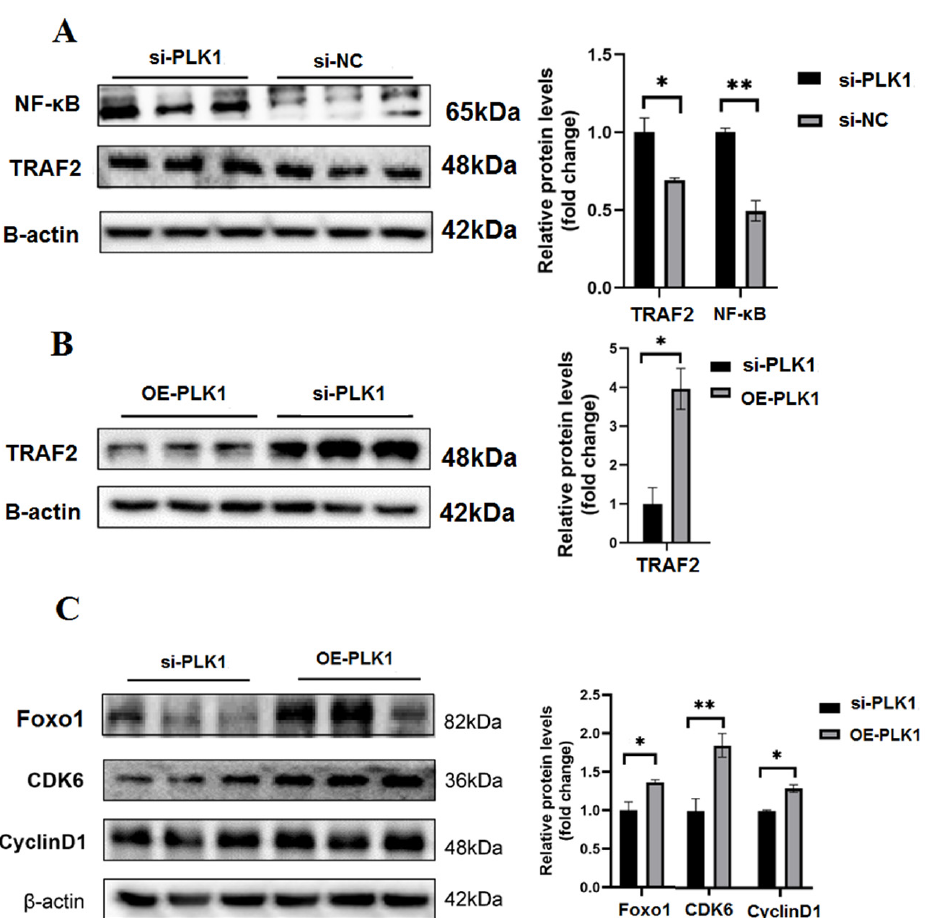
Figure 6. ( A ) The NF- κ B signaling pathway is impacted by PLK1 inhibition. After PLK1 downregula- tion, NF- κ B and TRAF2 levels changed, as seen in the Western blotting analysis; ( B ) WB to evaluate alterations in the levels of TRAF2 in the si-PLK1 and OE-PLK1 group; ( C ) WB to evaluate alterations in the levels of FoxO1, CDK6, and cyclinD3 in the si-PLK1 and OE-PLK1 group; * p < 0.05, ** p < 0.01.